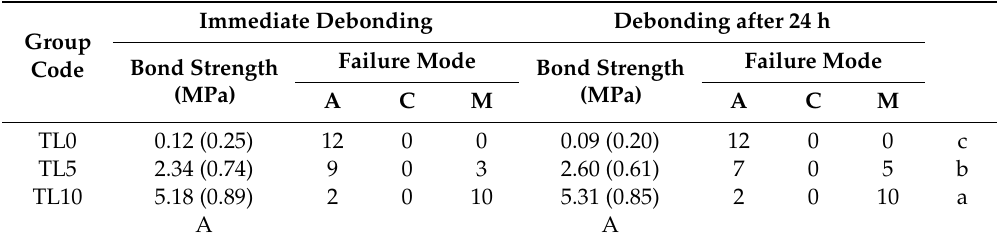
Table 2. Shear bond strengths and failure modes of three TheraCal LC materials at two different debonding times (means (standard deviations), n = 12/group).